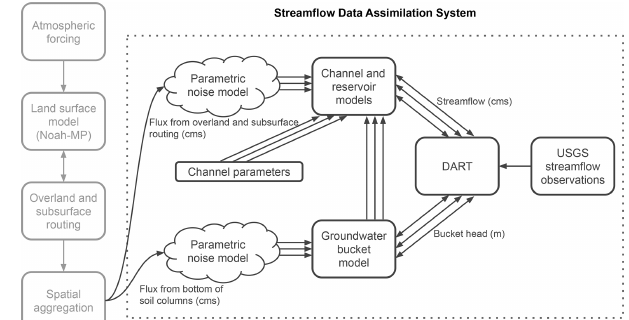
Figure 2. Streamflow data assimilation system overview. Vertical boxes on the left show the deterministic NWM model chain from forcing through aggregation of (overland, subsurface, and column drainage) routing output fluxes. These output fluxes are the inputs to the data assimilation system used in this paper, shown inside the dotted box. Random noise is applied to these inputs to generate en- semble forcings. Ensembles are denoted by groups of three arrows (the ensemble size is much larger than three). The ensemble fluxes drive the ensemble model components (channel and reservoir model and groundwater bucket model) used in the assimilation. The de- picted time-invariant a priori error distribution of channel parame- ters provides a multiphysics streamflow ensemble. The groundwater states produce additional fluxes to the channel and reservoir model. The spatially distributed streamflow and bucket head states com- prise the state vector passed to DART for updating by USGS stream- flow observations. The unit cms denotes cubic meters per